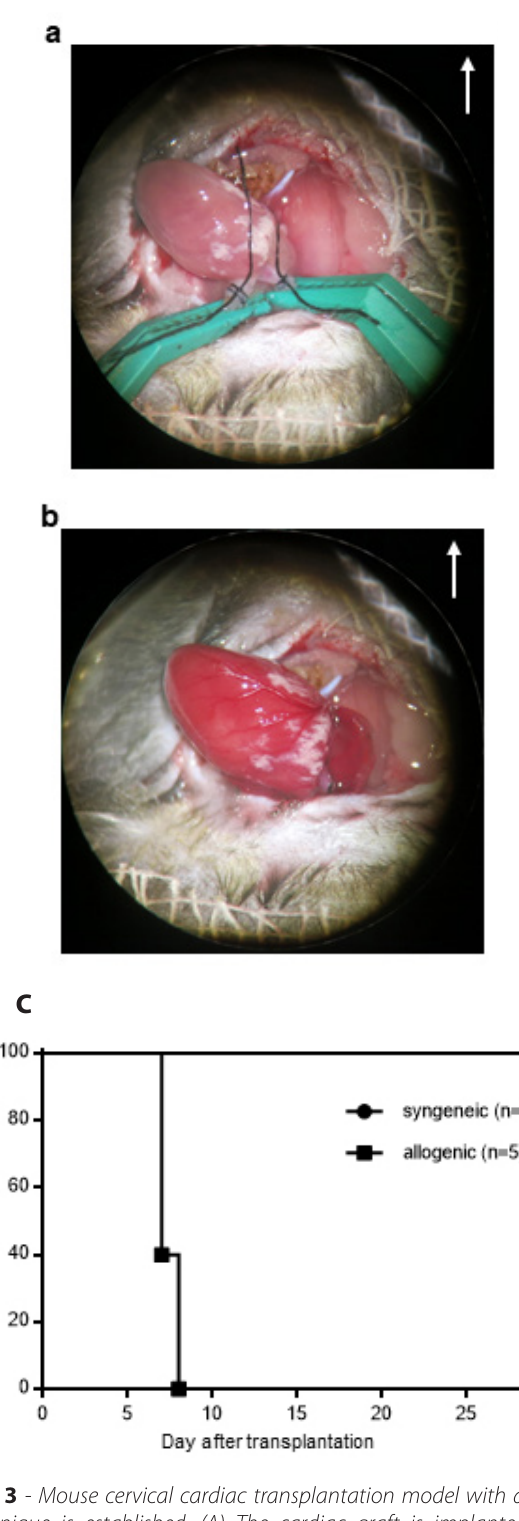
Fig. 3 - Mouse cervical cardiac transplantation model with a cuff technique is established. (A) The cardiac graft is implanted. (B) Recipient blood perfuses the cardiac graft. (C) Survival curve of the syngeneic or allogeneic grafts. The white arrow points toward the head of the recipient